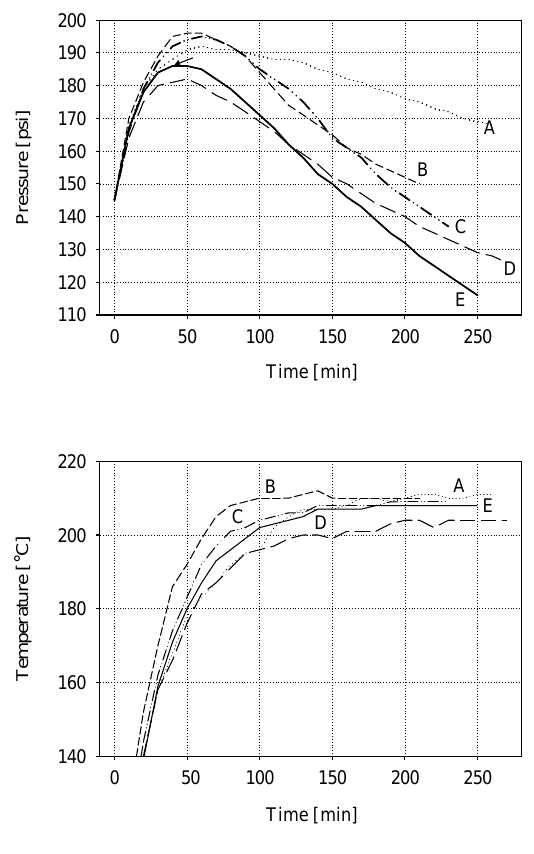
Profiles for hydrogenation runs: (A) without material, (B) with Mg-1 at % Ni (cid:1) 30 min, and (C) with Mg-1 at % Ni (cid:1) 90 min, (D) with Mg-2 at % Ni (cid:1) 30 min, and (E) with Mg-2 at % Ni (cid:1) 90 min. The initial temperature was